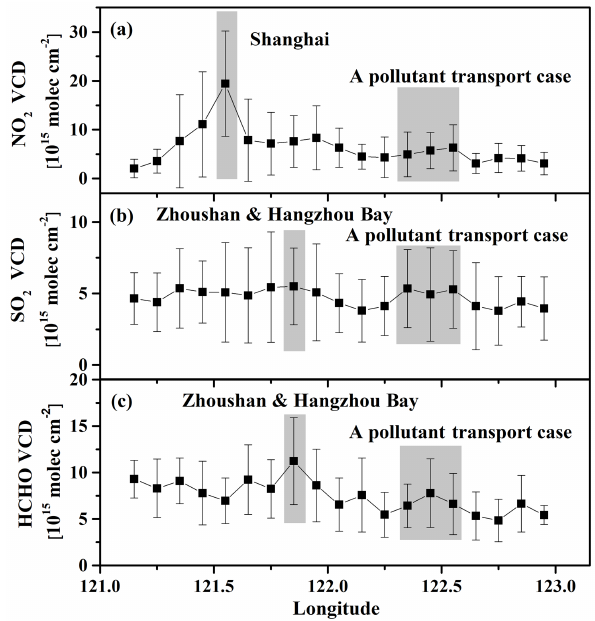
Figure 4. The variations in trace gas tropospheric VCDs with lon- gitude: (a) NO 2 , (b) SO 2 , and (c)